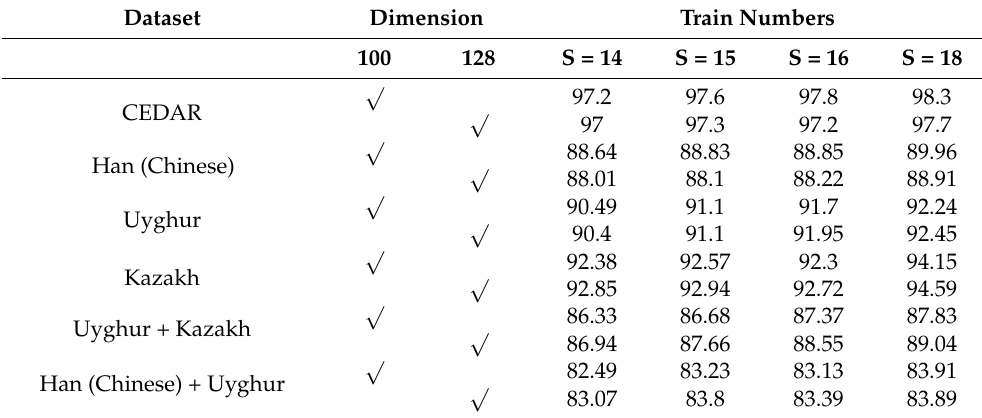
Table 2. Recognition results of Lomo features of different dimensions.